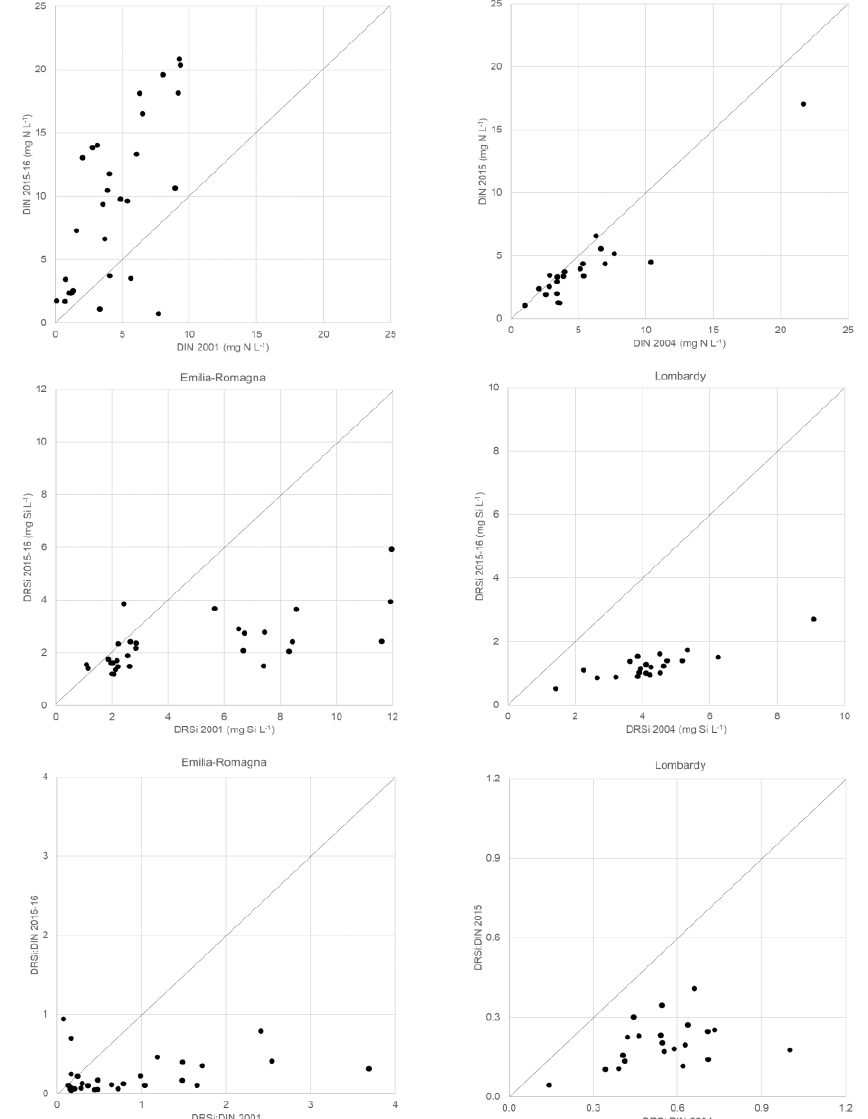
Figure 5. Comparison between DIN and DRSi concentrations, and DRSi to DIN molar ratio (except for PR39, which scores lie outside the graph) for springs of Emilia-Romagna and Lombardy in 2015– 2016 and in previous studies. Note that axis scales are different for each graph.